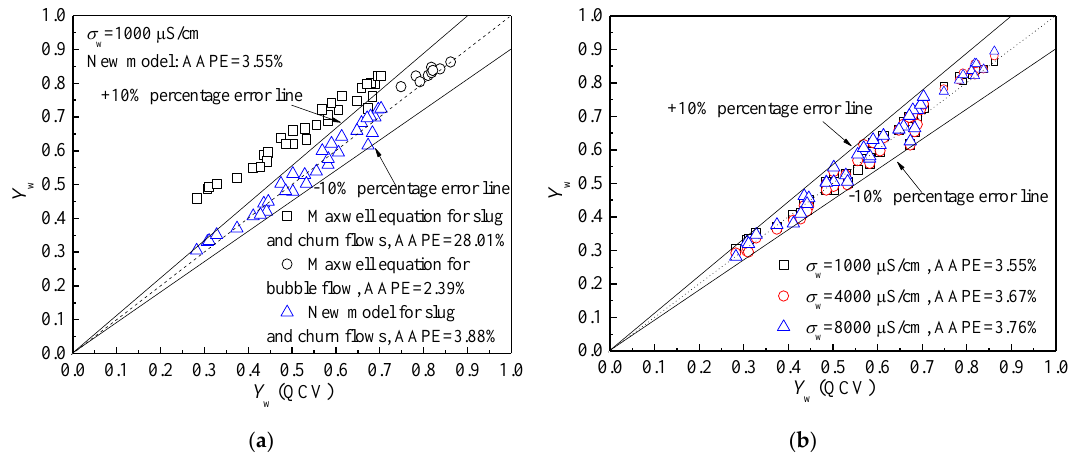
Figure 10. The calculation results using the new model: ( a ) Result comparison using the Maxwell equation and new model when the water conductivity is 1000 μS/cm ; ( b ) Salinity independent water holdup measurement using the new model.